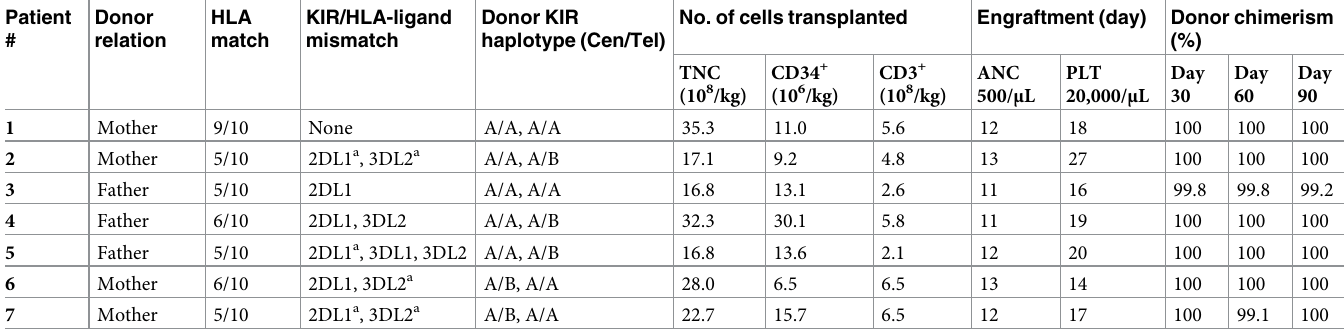
Table 2. Graft information, engraftment, and chimerism. Patient